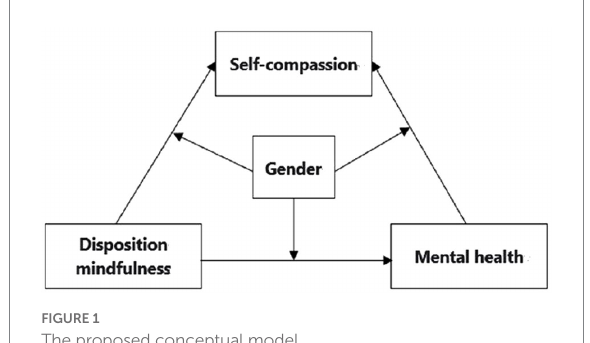
FIGURE 1 The proposed conceptual